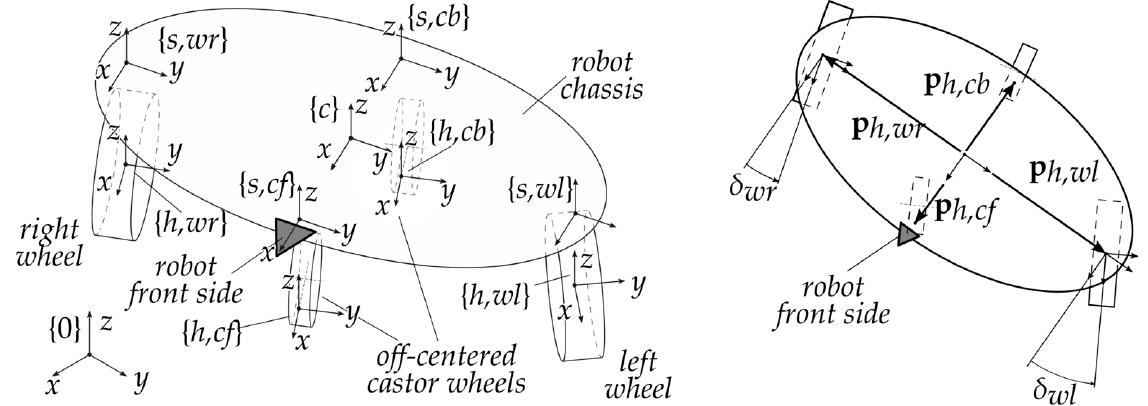
Figure 2. Position of the bodies reference frames within the PAQUITOP kinematic structure. The platform is provided with two independent actuated steering wheels to achieve omnidirectional mobility in the plane, but due to this actuation redundancy the joint variables ϑ ∼ and δ ∼ need to be assumed considering the constraint: